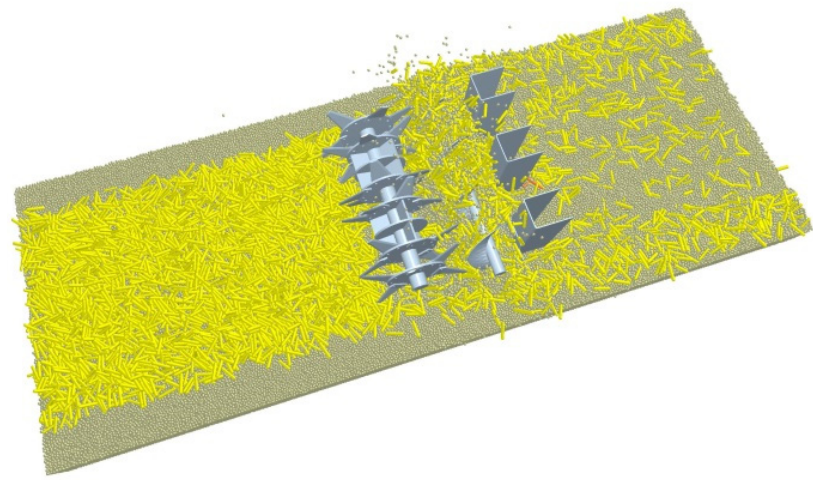
Figure 7. Simulation operation process of the SDARD.